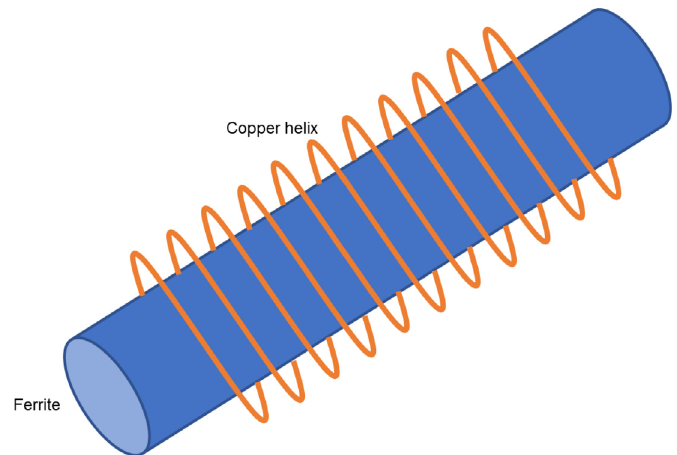
Fig. 11. Schematic diagram of ferrite NPM unit wrapped by spiral coil.